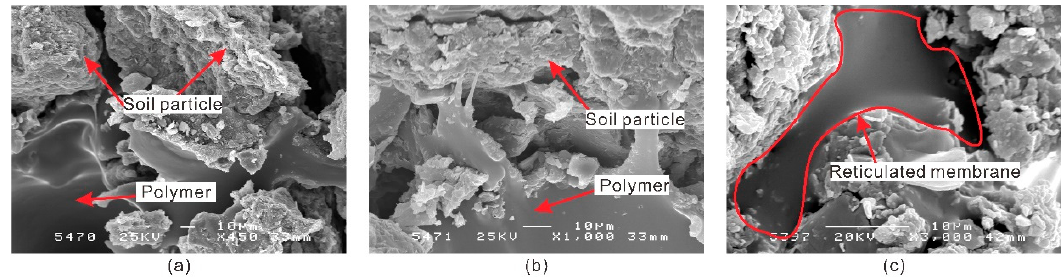
Figure 3. SEM image of section of inner soil modified with polymer: ( a ) ×450; ( b ) ×1000; ( c ) ×3000.